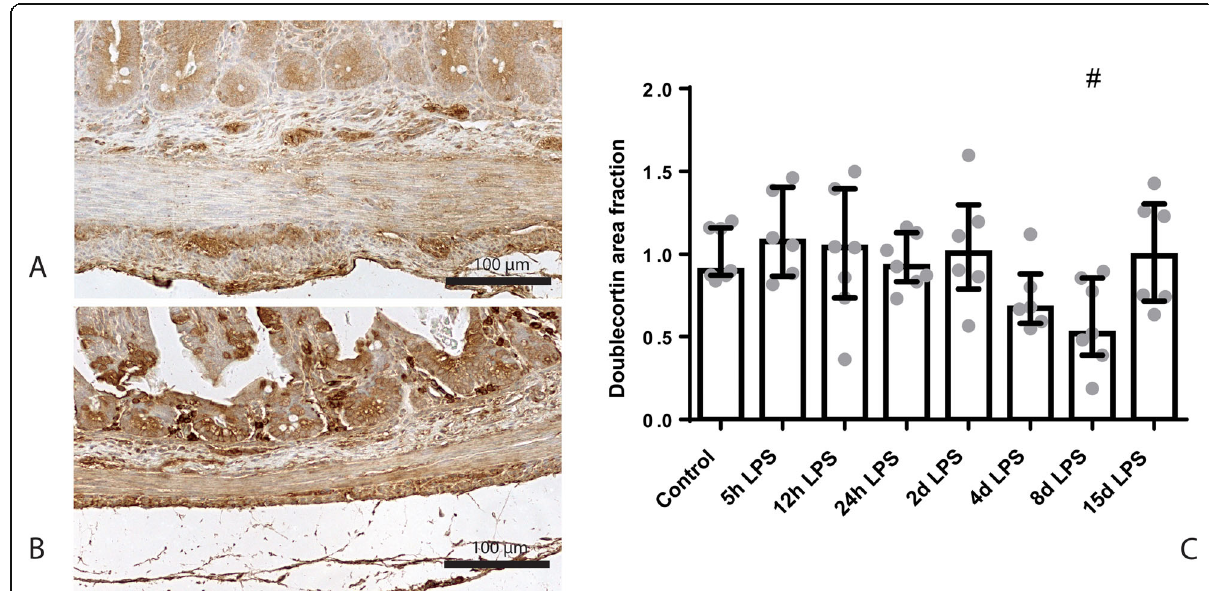
Fig. 5 Representative images of doublecortin immunoreactivity in the submucosal and myenteric plexus of the control ( a ) and 8 days of IA LPS group ( b ). Area fraction of doublecortin in the myenteric plexus ( c ) as fold increase over the control value. c Doublecortin-positive surface area